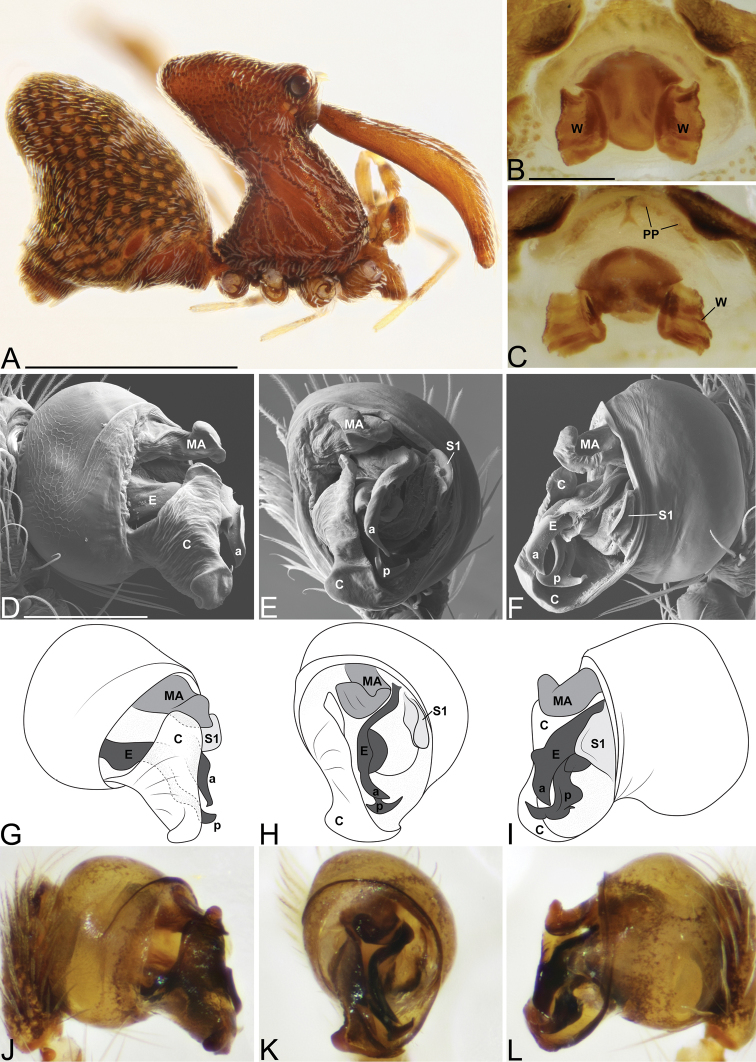

Madagascarchaea
jeanneli (Millot, 1948). A male (CASENT9004085) habitus, lateral view, image reversed B–C female (CASENT9012336) internal genitalia B dorsal view C anterior view. D–L male pedipalpal bulbs D–I left bulb (CASENT9004085) J–L left bulb (CASENT9005233): D, G, J prolateral view E, H, K ventral view F, I, L retrolateral view. Scale bars: 1 mm (A); 0.125 mm (B, D).